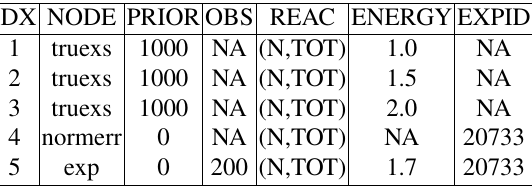
Table 1. Structure of a data table with the definition of the variables of the Bayesian network